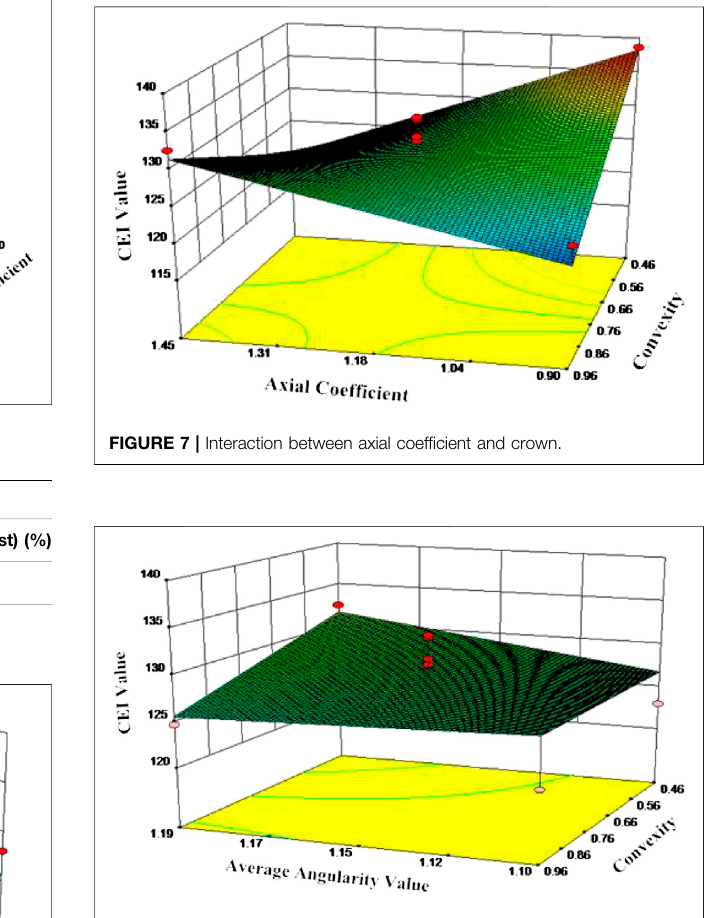
FIGURE 8 | Interaction between angularity and convexity.